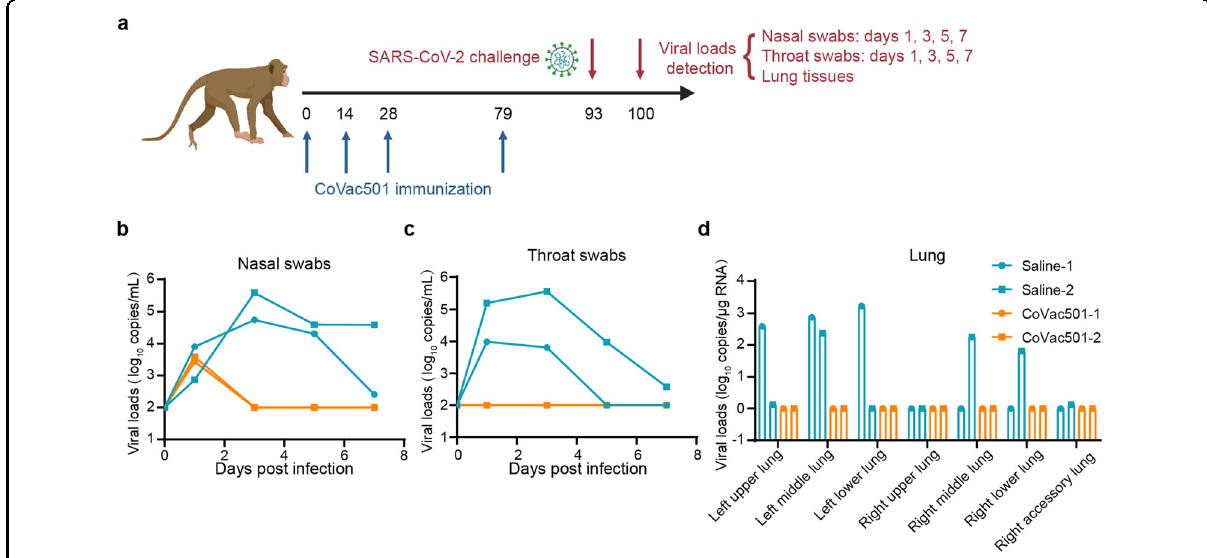
Fig. 6 Protective ef fi cacy against SARS-CoV-2 challenge in cynomolgus macaques. a Schematic diagram of immunization, SARS-CoV-2 challenge, sample collection, and detection in cynomolgus monkeys. Cynomolgus monkeys ( n = 2) were challenged with a SARS-CoV-2 virus dose of 1 × 10 7 TCID 50 (20% nostril and 80% trachea) 14 days after a booster immunization on day 79. Nasal and throat swabs were collected 1, 3, 5, and 7 days after the challenge. The viral load in the lung tissues was determined seven days after the challenge. b Viral load detection for nasal swab samples during the challenge. c Viral load detection for throat swab samples during the challenge. d Viral load detection for left and right lung lubes after